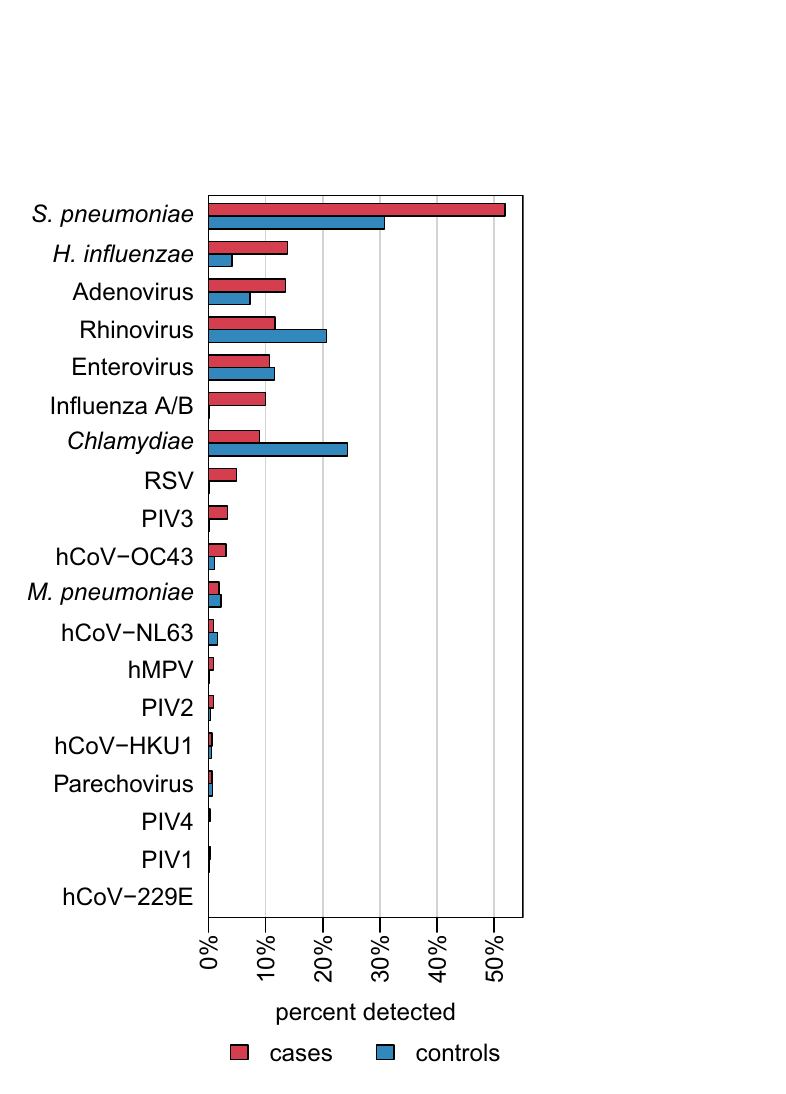
Figure 2. Proportion of cases and controls with specific pathogens. Maximum number of isolates per case and control was six. On average 1.4 (SD: 1.1) isolates per case and 1.1 (SD: 1.2) isolates per control were